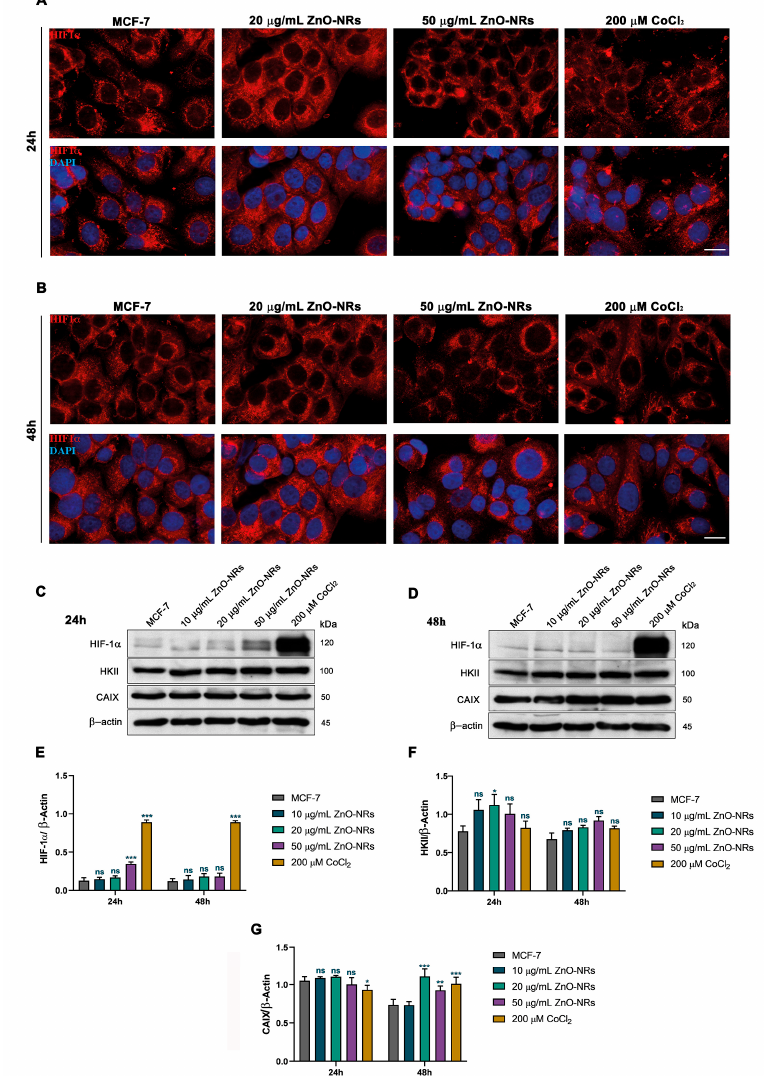
Figure 5. ZnO-NRs’ effects on HIF-1 α expression and localization in MCF-7 cells. MCF-7 cells were either untreated or treated with the indicated ZnO-NR concentration for 24 and 48 h. ( A ) HIF-1 α nuclear translocation (red fluorescence) after 24 h treatment with 20 and 50 µ g/mL ZnO-NRs. Nuclei were stained with DAPI (blue fluorescence), 40 × magnification. ( B ) HIF-1 α nuclear translocation (red fluorescence) after 48 h treatment with 20 and 50 µ g/mL ZnO-NRs. Nuclei were stained with DAPI (blue fluorescence), 40 × magnification. ( C,D ) HIF-1 α , HKII, and CAIX protein expression after 24 and 48 h treatment with 10, 20, and 50 µ g/mL ZnO-NRs. ( E – G ) Densitometric analysis of HIF-1 α , HKII, and CAIX protein expression after 24 and 48 h treatment with 10, 20, and 50 µ g/mL ZnO-NRs. Experiments were repeated three times. * p < 0.05, ** p < 0.01, and *** p < 0.001. ns, not significant. In all experiments, hypoxia, induced by 200 µ M CoCl 2 , was used as positive control. β -actin was used as loading